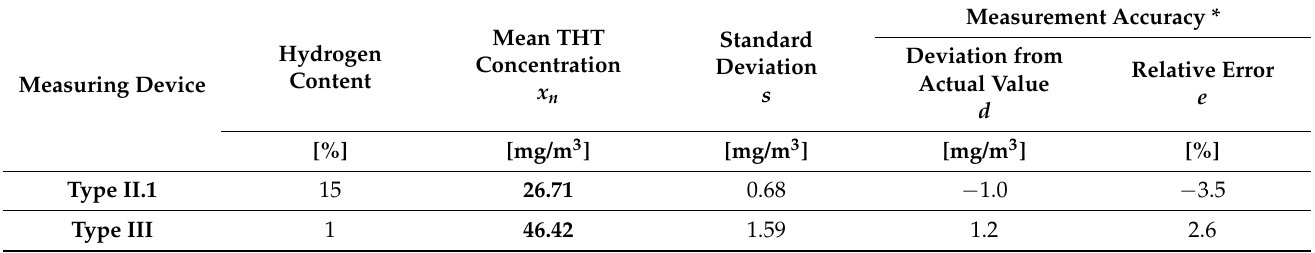
Table 8. Results of long-term studies on the impact of hydrogen on the quality of THT concentration measurements in methane-hydrogen mixtures, for analyzers with an electrochemical sensor